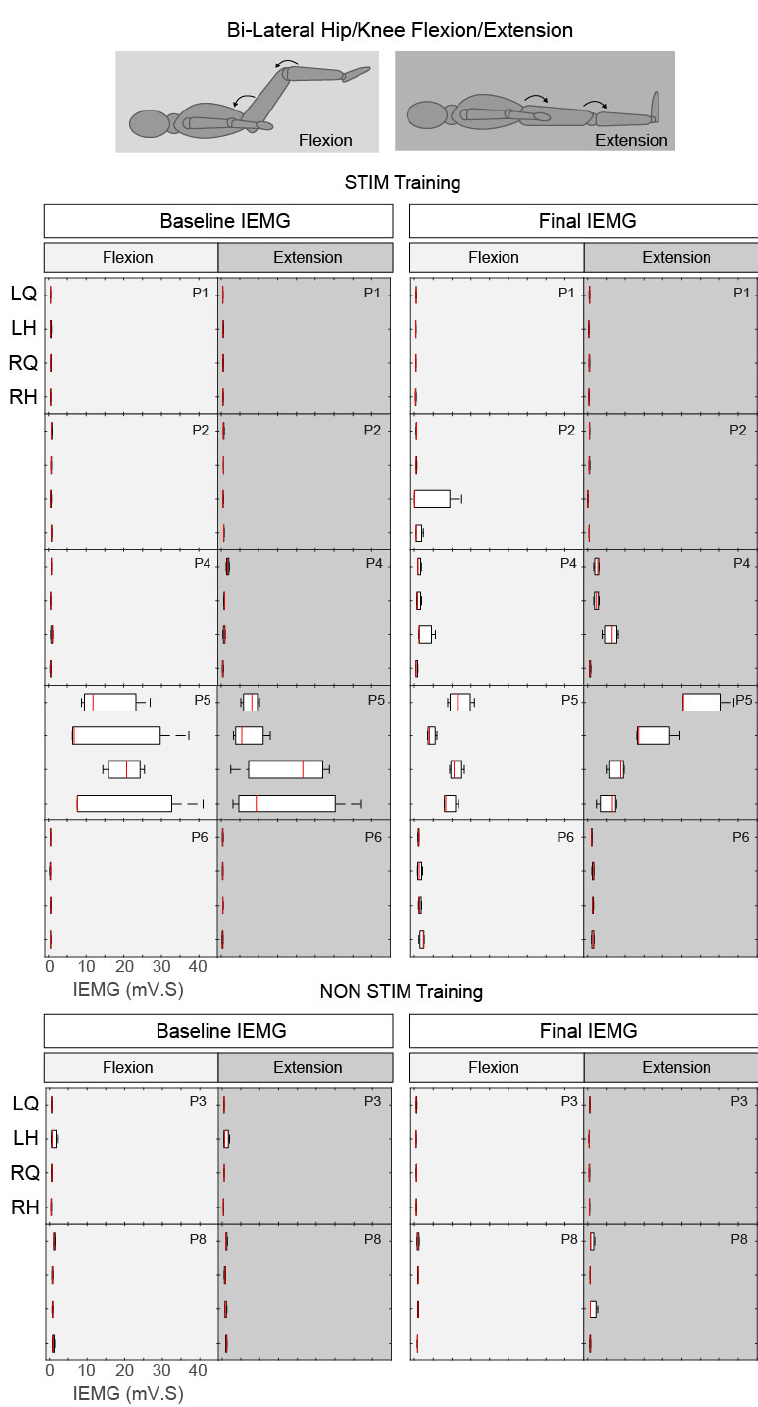
Figure 4. Box plots of integrated EMG activity recorded from the left (L) and right (R) quadriceps (Q) and hamstrings (H) during hip/knee flexion (light grey) and extension (dark grey) movements without tSCS, before (Baseline) and after (Final) the intervention, for all participants. Patterns of integrated EMG (IEMG) (averaged over 3 trials) are displayed for each participant during both flexion and extension phases. Each plot indicates the 25–75th percentiles (box), minimum and maximum values (whiskers), and median value (central red line).